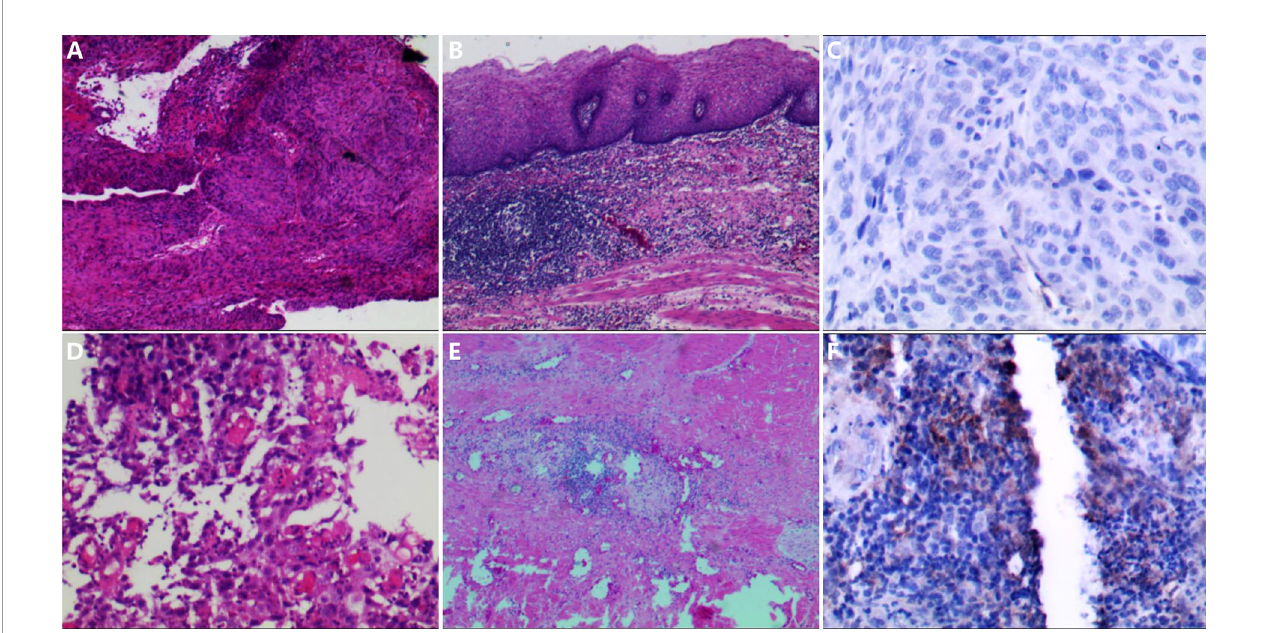
FIGURE 3 | The pathological changes before and after neoadjuvant chemoimmunotherapy and the PD-L1 expression. (A, B) The pathological changes in patient 1; after neoadjuvant chemoimmunotherapy, the tumor cells disappeared, and many lymphocytes in fi ltrated. (C) The expression of PD-L1 combined positive score (CPS) in the sample before therapy in patient 1; and the expression of PD-L1 CPS was lower than 1. (D, E) The pathological changes in patient 4; after neoadjuvant chemoimmunotherapy, the tumor cells disappeared, and some lymphocytes in fi ltrated. (F) The expression of PD-L1 CPS in the sample before therapy in patient 4, and the expression of PD-L1 CPS was 10.